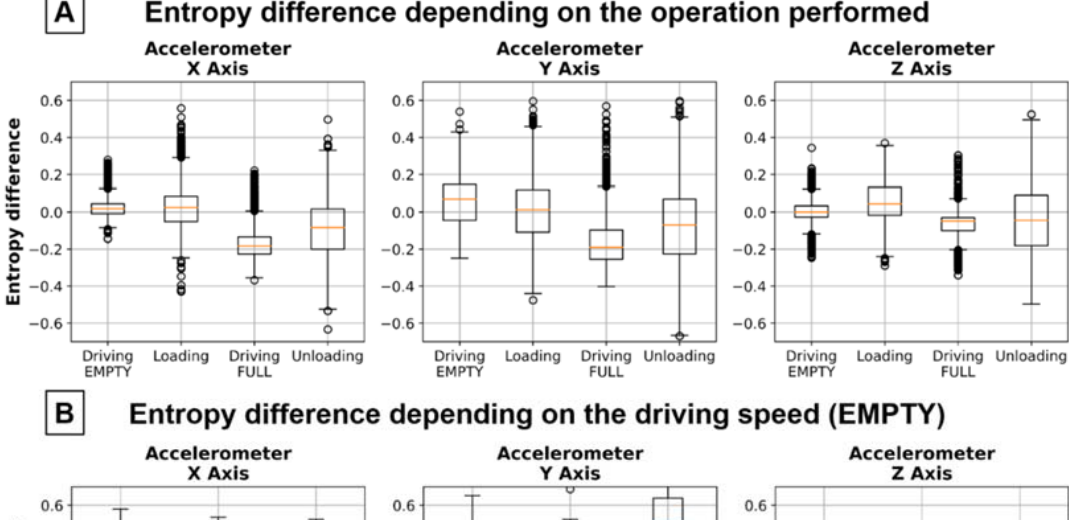
Figure 6. Entropy analysis during experimental driving over bumps. The spectral entropy of the Z ‐ axis accelerometer for the front and back of the machine and the absolute difference between the entropy measured at the front and the back.